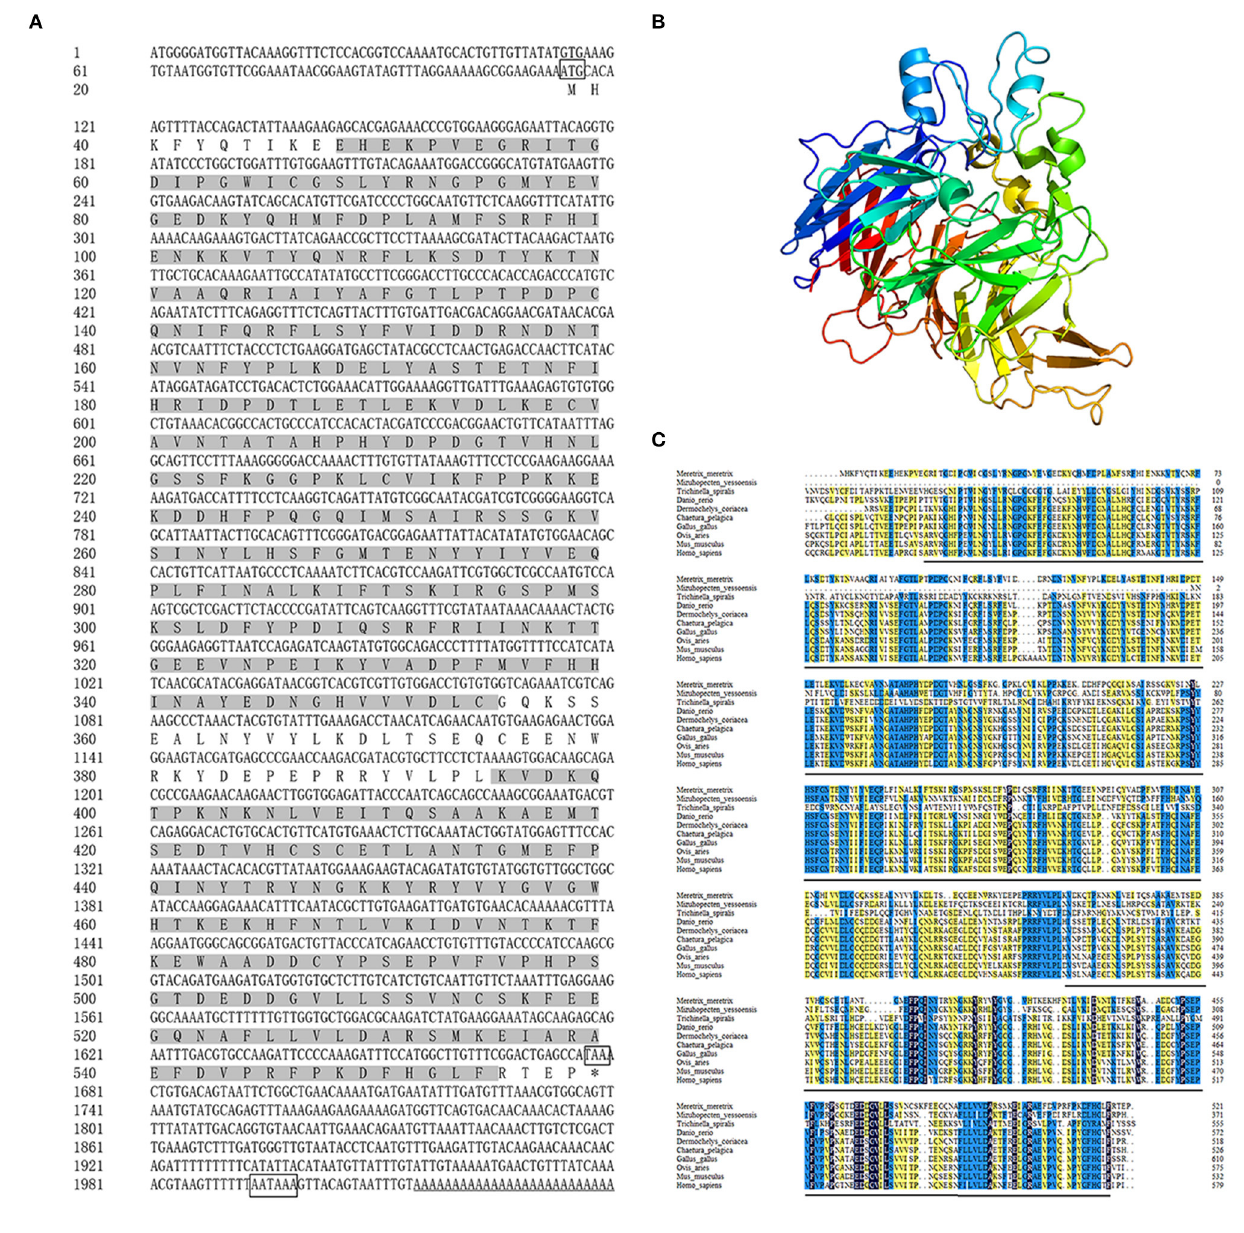
FIGURE 1 | The information of the Mm-BCDO2 gene. (A) The full length of cDNA and deduced amino acid sequence of Mm-BCDO2 . The frames represented the start codon, the stop codon, and polyadenylation signal. The gray background fill is the functional domain of RPE65. (B) The structure of Mm-BCDO2 protein. The arrow structure elements are β -strand, the helical structure elements are α -helix, and the others are random coils and turns. (C) Multiple alignments of amino acid sequences of BCDO2 from M. meretrix and other model species. Among these, the completely ( = 100%), strongly ( ≥ 75%), and weakly ( ≥ 50%) conserved residues are shaded in black, blue, and yellow, respectively. The black line represents the domain